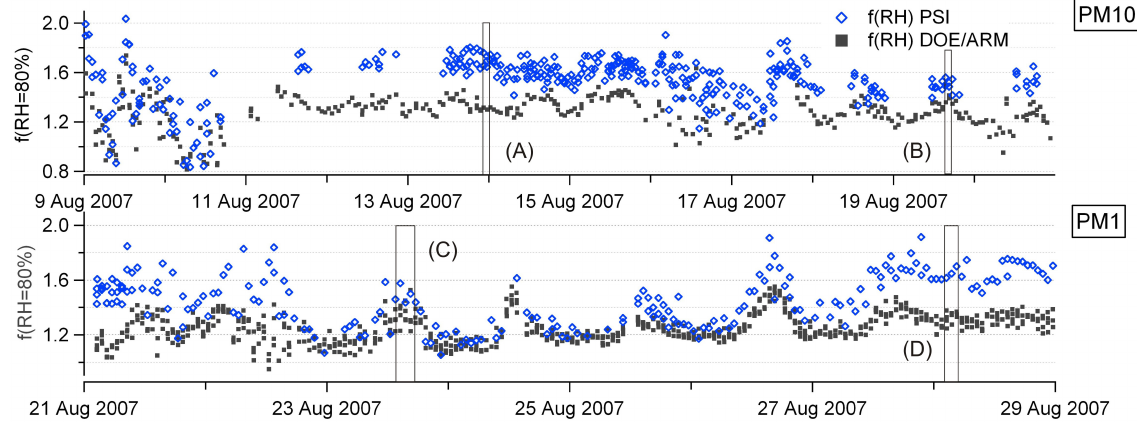
Fig. 4. PM 10 and PM 1 f (RH=80%) measured with the humidified nephelometer of DOE/ARM and PSI. Time resolution is 1min. (A) to (D) indicate the periods when the humidograms presented in Fig. 5 were